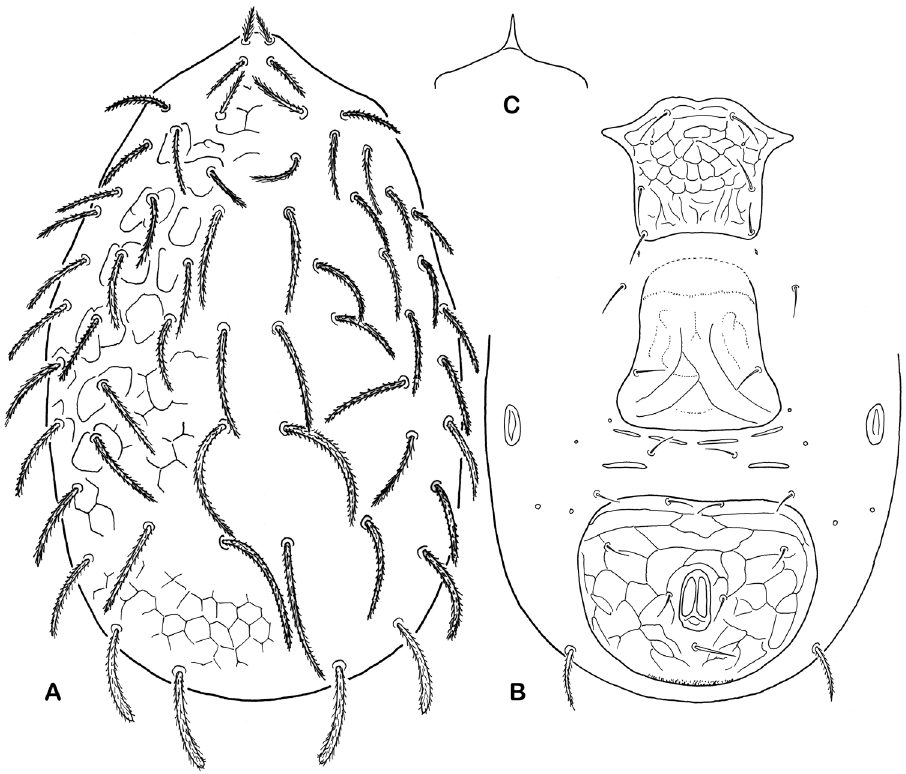
Figure 4. Kleemannia miranda sp. n., female. A Dorsal idiosoma B Ventral idiosoma. Not scaled. level of st2), weakly reticulate on surface, with three pairs of setae (st1–st3). A pair of poroid structures associated with st3 on soft integument close to posterolateral corners of sternal shield. Pseudo-metasternal platelets absent. Metasternal setae (st4) on soft integument. Epigynal shield 86–90 μm wide, oblong, slightly expanded behind geni- tal setae, tongue-shaped, with indistinct reticulate pattern and a pair of genital setae (st5). Three pairs of postgenital sclerites present. Metapodal platelets suboval, relatively small. Peritremes and peritrematal shields normally developed. Ventrianal shield 125– 140 μm wide and 100–110 μm long, straight or very slightly concave anteriorly and widely rounded posteriorly, almost dish-shaped, well reticulate on surface, having three circum-anal setae, two pairs of opisthogastric setae and anus in its posteromedial por- tion. Except for JV5, all ventrally situated setae smooth and needle-like; sternal setae about 25 μm in length, slightly longer than ventral and adanal setae (15–17 μm), and postanal seta (20 μm). Setae JV5 of similar form and length as those on dorsal shield, 46–48 μm long. Epistome with central spine-like process. Setae h1 thickened. Fixed digit of chelicera with four small teeth on proximal masticatory area. Other gnathoso- mal structures and leg chaetotaxy typical of